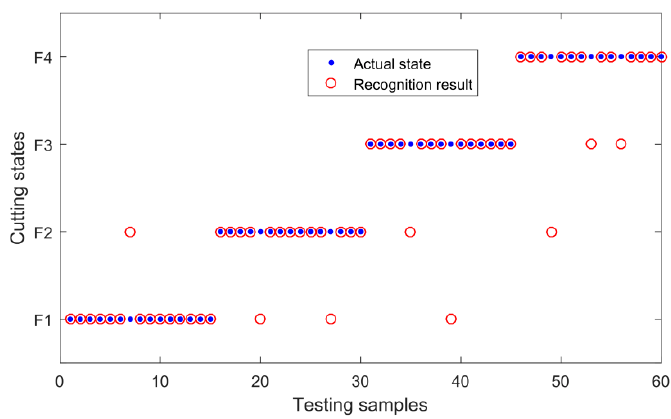
Figure 20. Recognition results without using the tracking area.